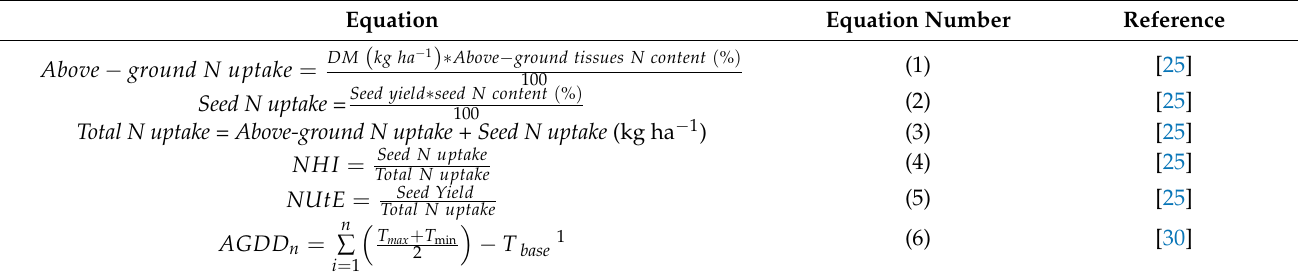
Table 6. The equations used in the present study and their corresponding number. Equation Equation Number